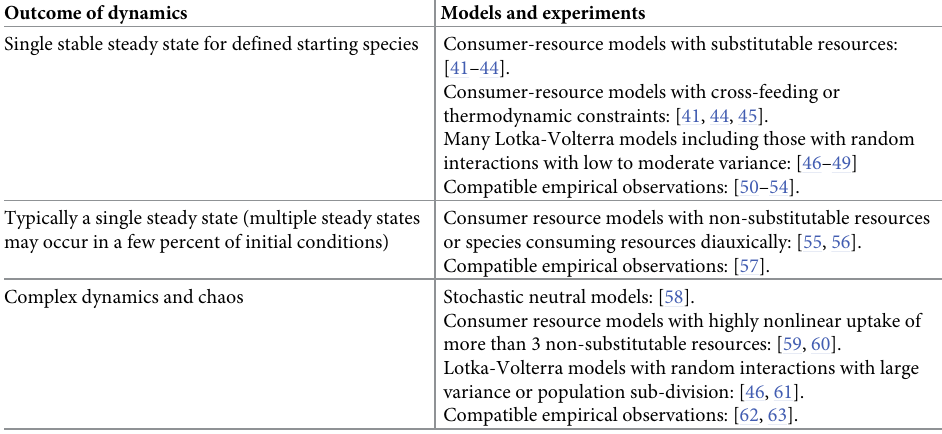
Table 1. Microbial communities often converge to a unique stable steady state, but more complex dynamics are possible. By a single stable steady-state, we mean that the dynamics converge to a steady-state that is stable to invasion by species that had gone extinct en route . In other words, if a species present initially goes extinct and is absent from the final steady-state, then it can not invade the final community successfully. Thus species presence-absences in the initial community fully determine the outcome. Note that this table only approximately condenses a vast and complex literature; for a more thorough understanding we encourage the interested reader to consult the cited references. We have provided additional details regarding the cited studies in S1 Text Sec.1. Macroscopic organisms are discussed in Ref.